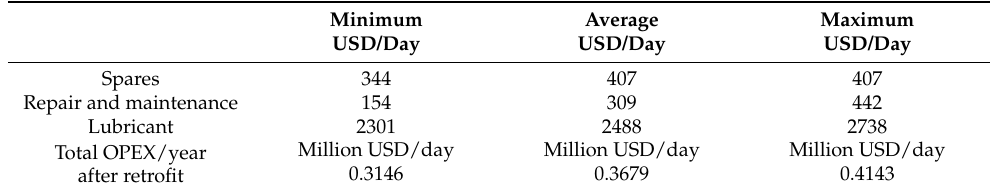
Table 4. OPEX Calculation per year.